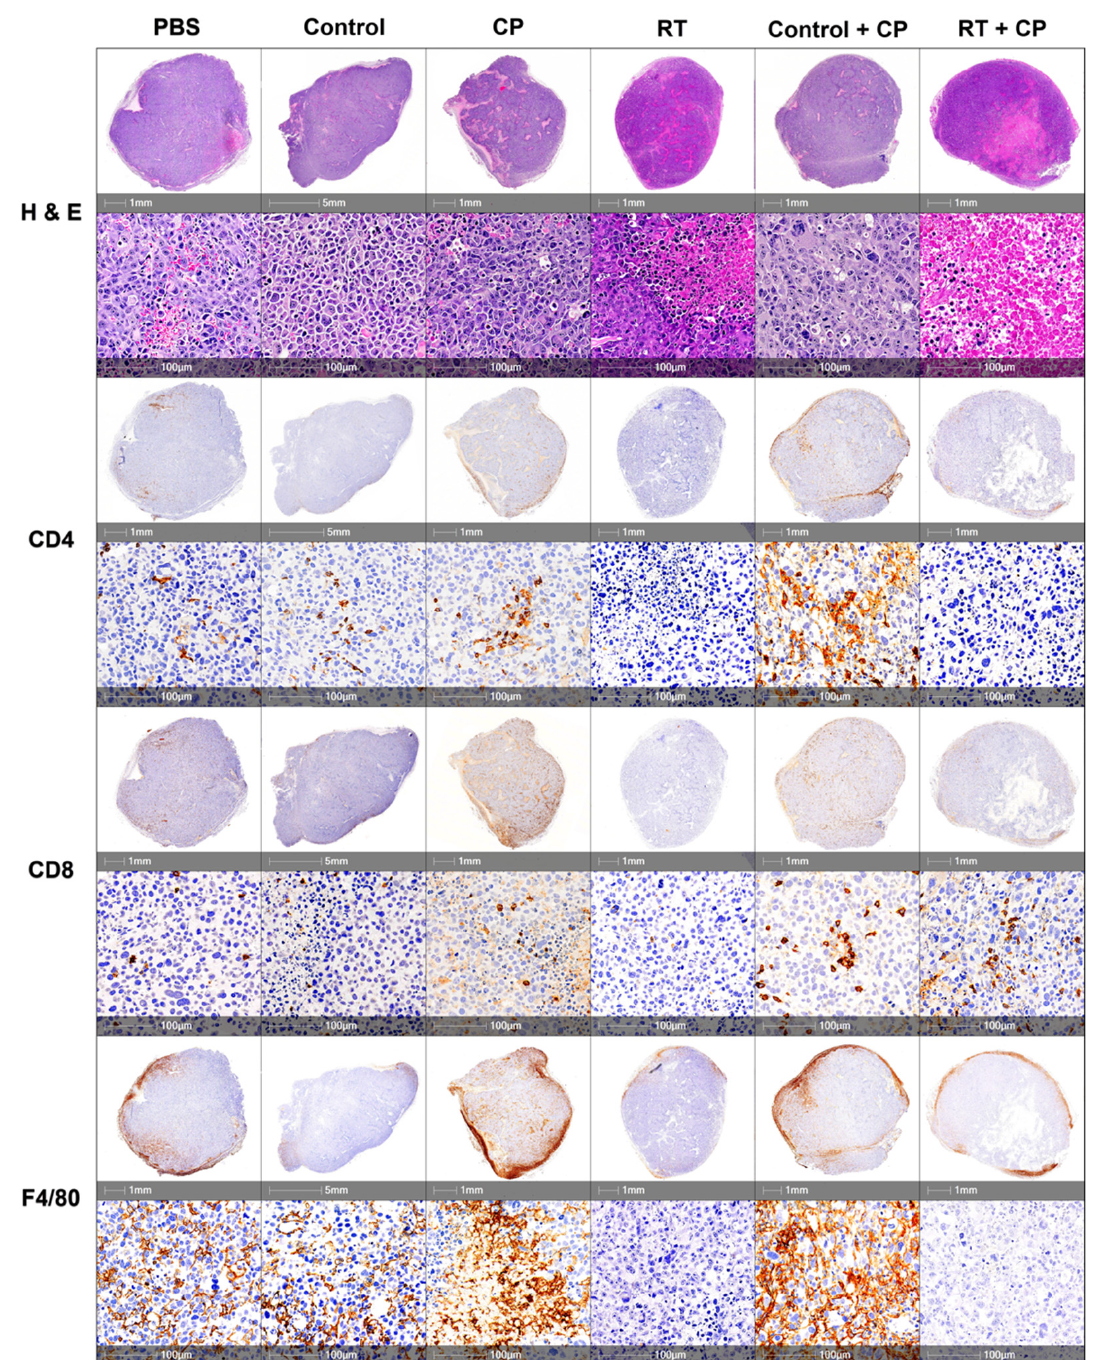
Figure 7. IHC analysis of immune cell infiltrates. C57/Bl6 mice bearing E0771 tumors were treated with PBS, control, CP, RT, control + CP, or RT + CP, and tumors were harvested on day 7. Tumors were sectioned and stained with H&E, CD4, CD8, and F4/80 for pathologic analysis. Each representative image shows a whole section of an individual tumor from the given group.